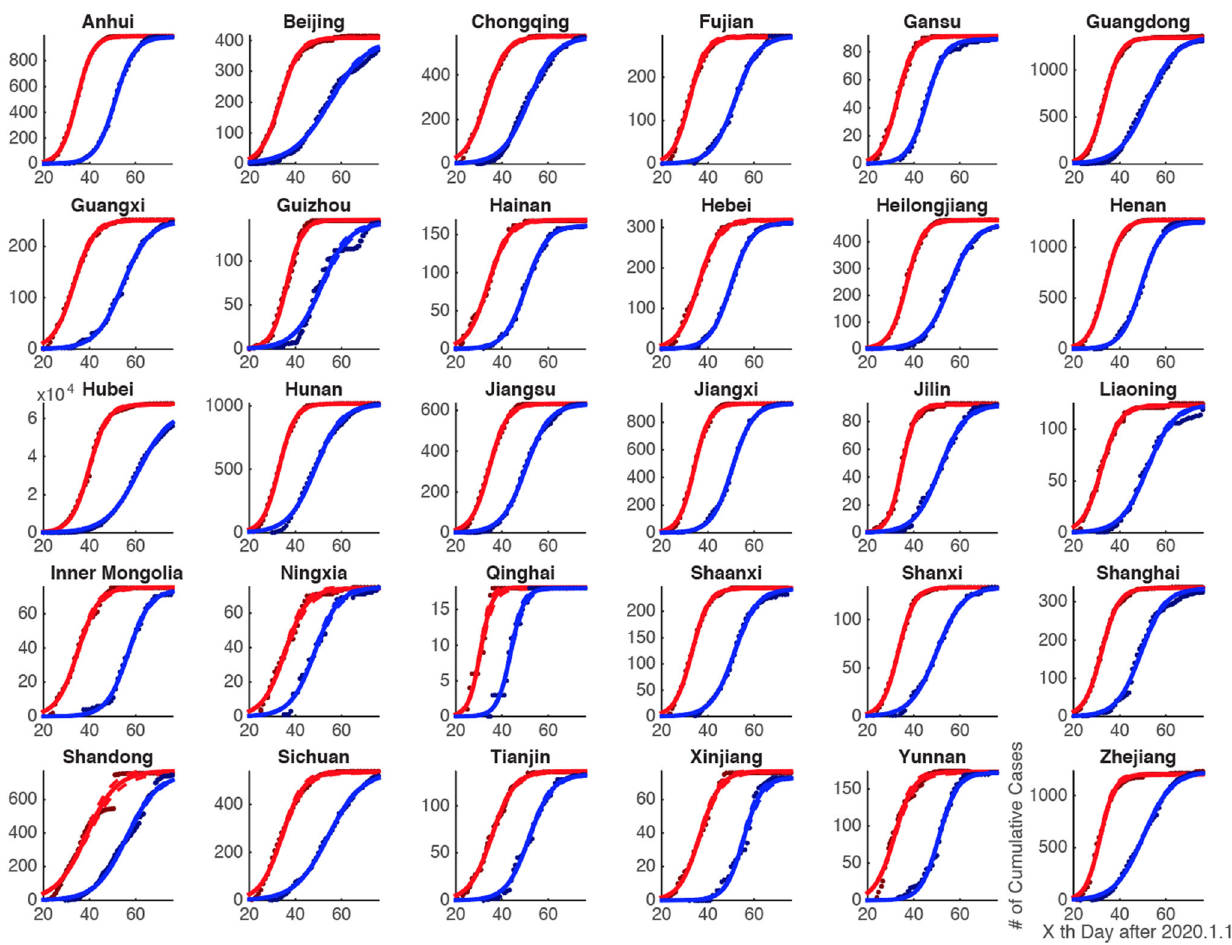
Fig. 2 Intrinsic growth rules of patients infected with the 2019 novel coronavirus in 30 provinces of